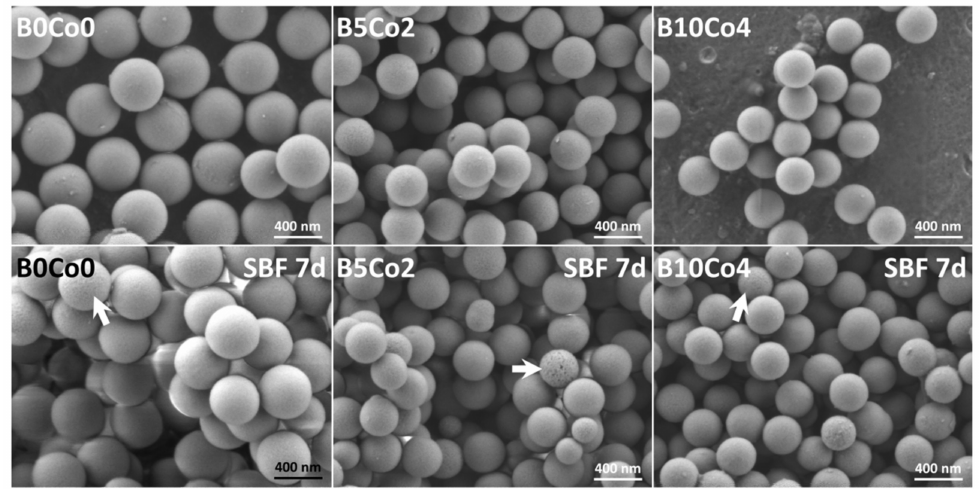
Figure 1. Scanning electron microscopy (SEM) images of the BCo.BGNs before and after immersion in simulated body fluid (SBF) for 7 days. The white arrows indicate nanoparticles exhibiting corrosion